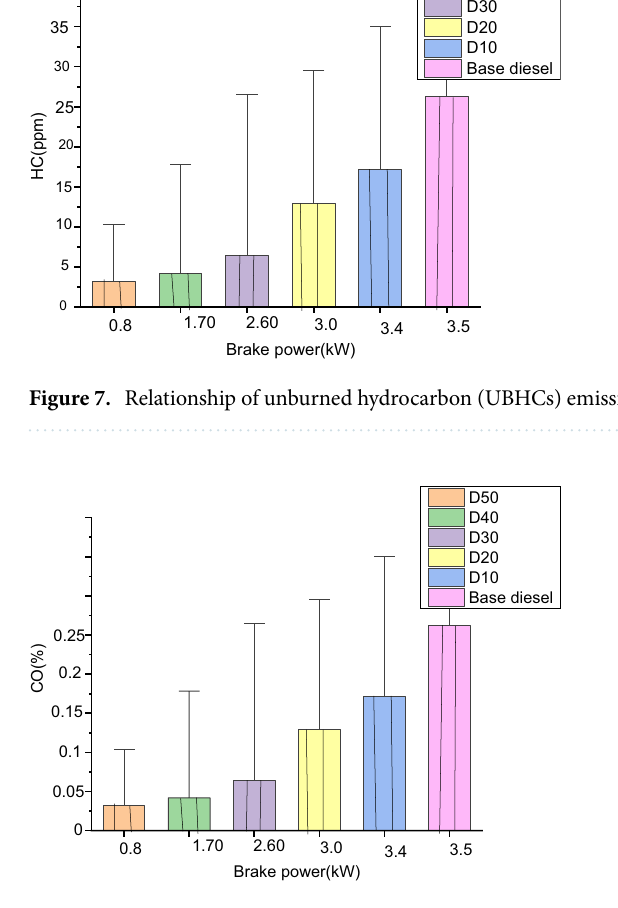
Figure 8. Comparison of carbon-monoxide emission for diverse blends of oxides of nitrogen